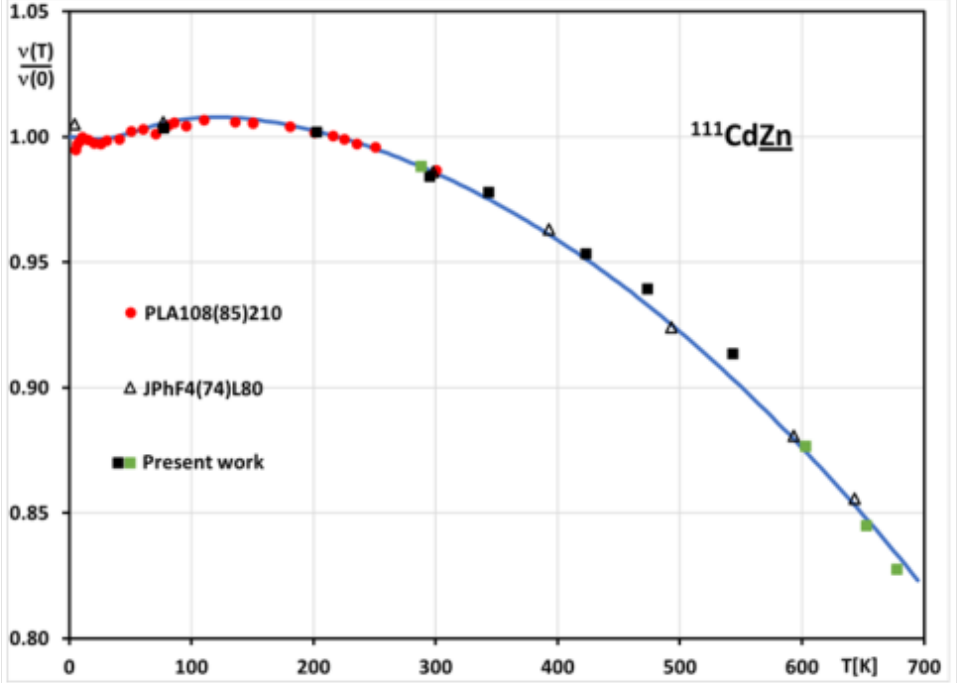
Figure 3. Normalized temperature dependence of EFG for Cd in Zn, including the present data; the green squares denote the results using the polycrystalline sample. The blue curve shows the one-parameter fit described in the text. References: JPhF4(74)L80 [14], PLA108(85)210